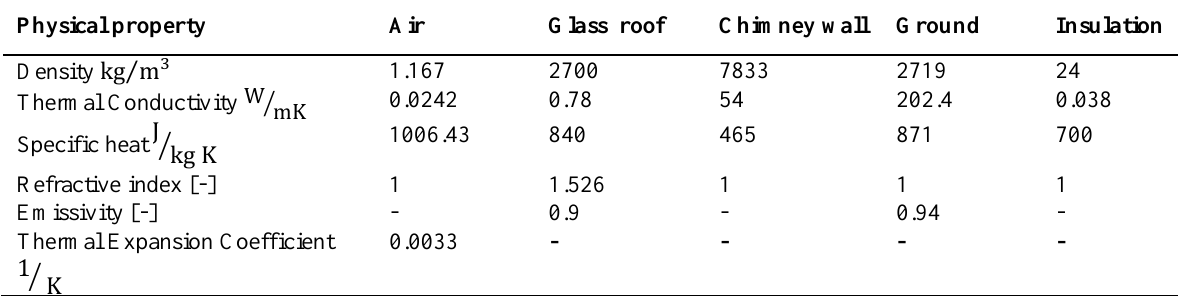
Physical properties of materials